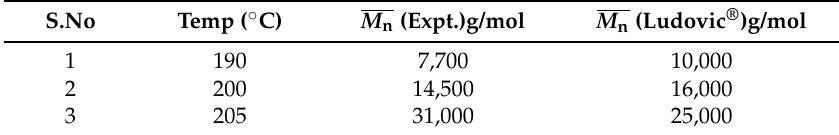
Table 5. Comparison between simulation results (“Ludovic ® ”) and experimental results